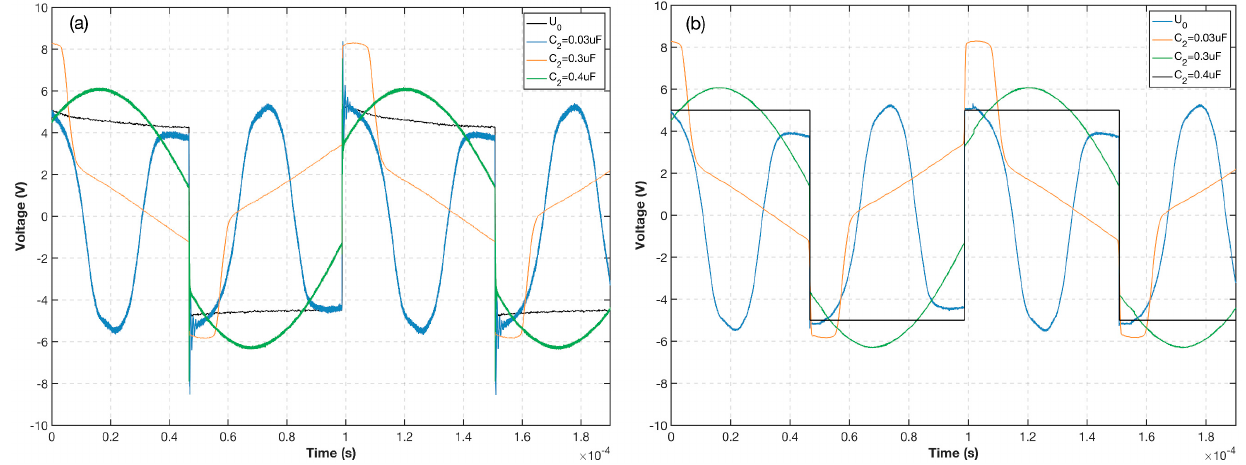
Figure 12. Comparison of excitation waveforms with di ff erent capacitors. ( a ) Experiment. ( b ) Simu- lation.